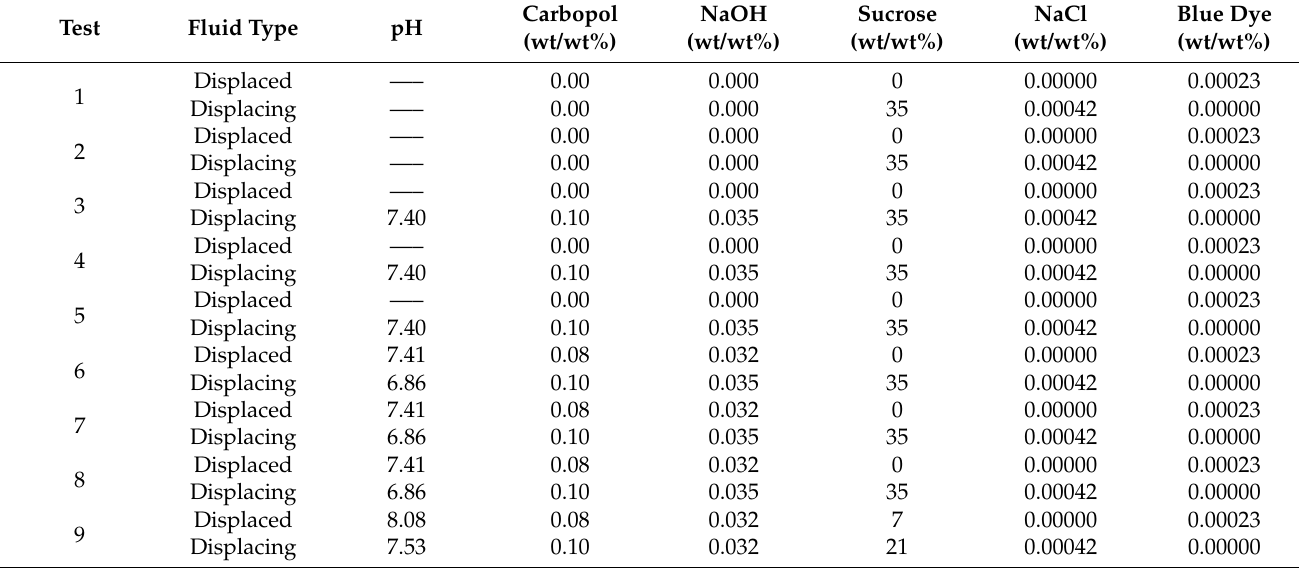
Table 2. Compositions and pHs of the displaced and displacing fluids.